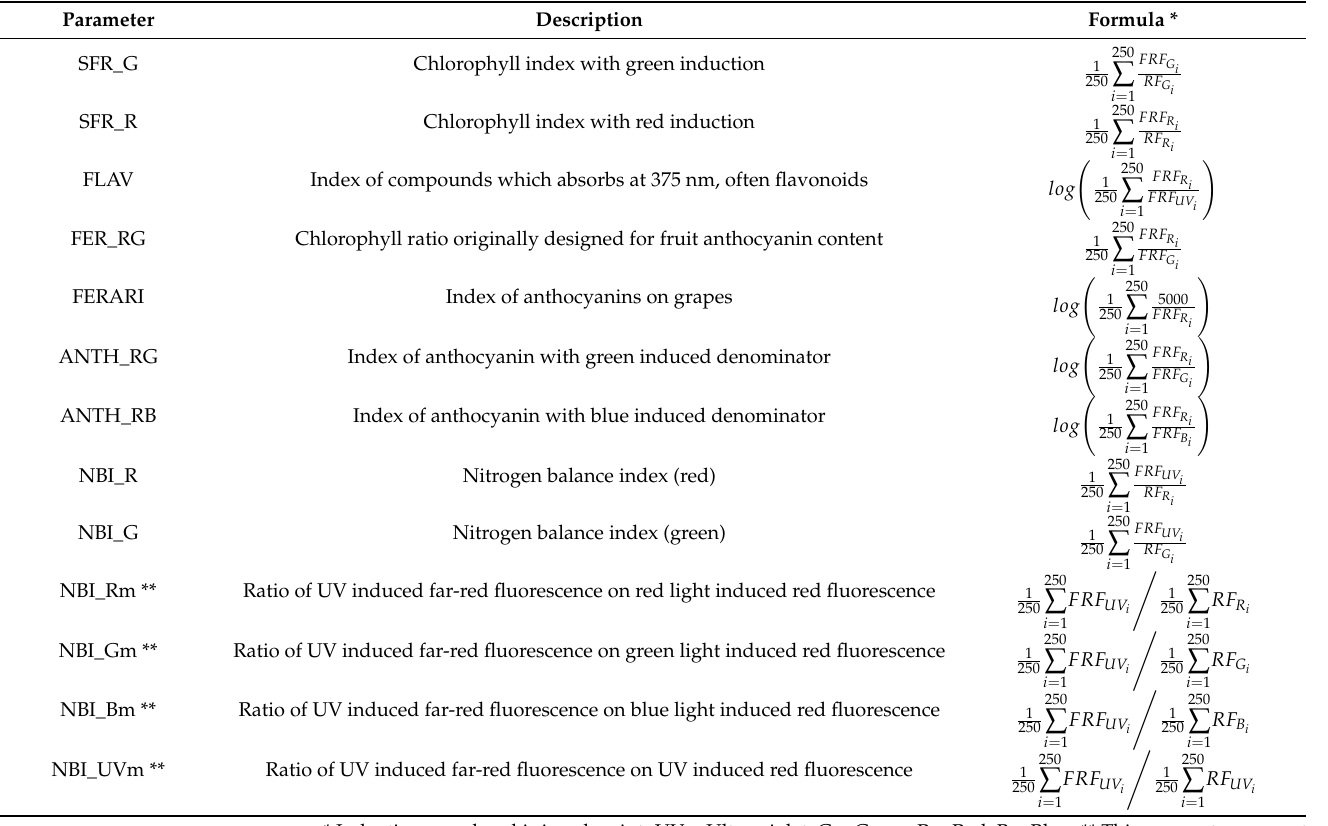
Table 3. Fluorescence indices used for this study along with their description and